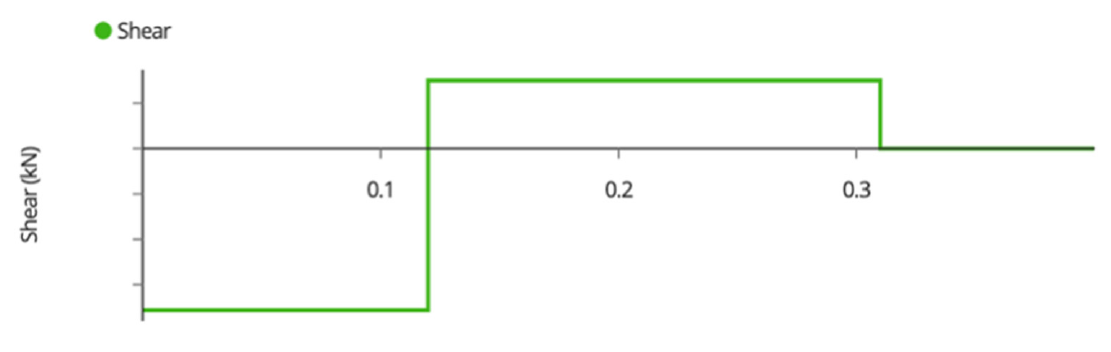
Figure A10. Post Shear Force Diagram.